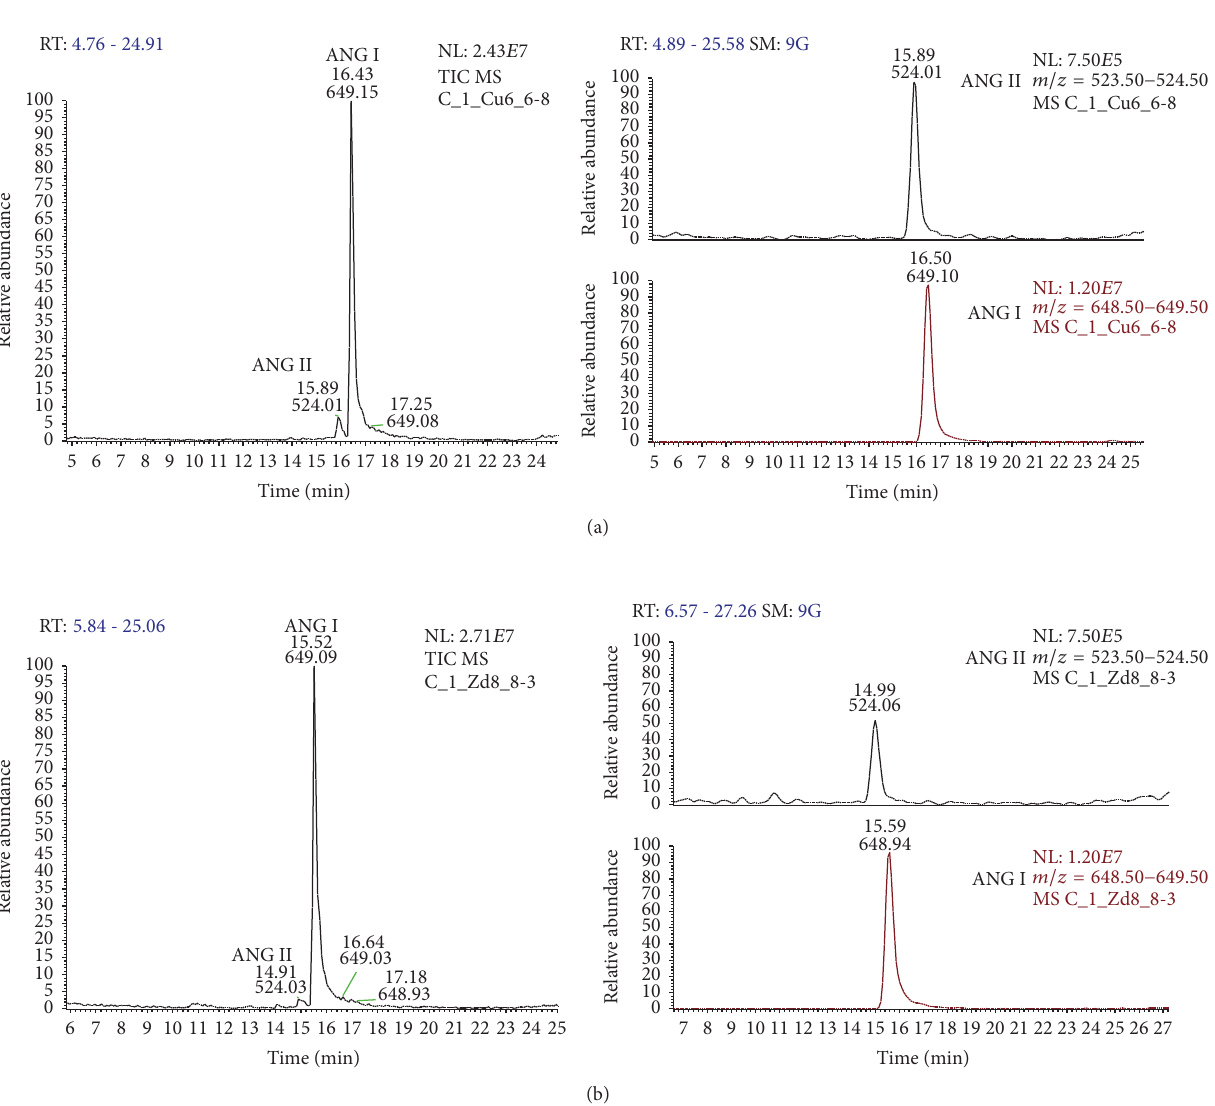
Figure 3: Representative chromatograms of products of ANG I conversion by aorta of STZ rats (a) and control rats (b). Left panel: TIC chromatogram (peaks represent relative abundance, 100% = ANG I); right panel: extracted chromatograms for monitored ions of ANG II and ANG I (unified scale).